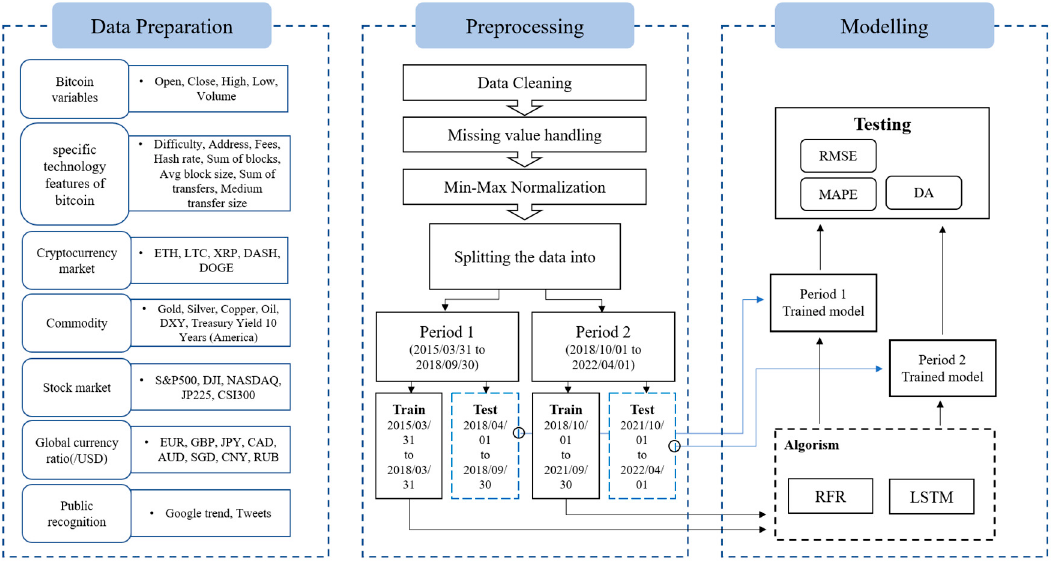
Figure 7. Model employed in this study.